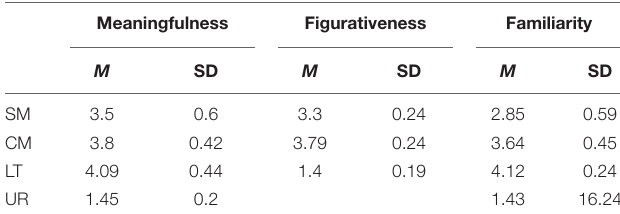
TABLE 2 | The results of